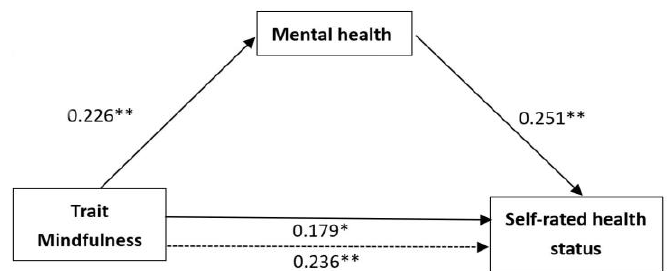
Figure 2. The mediation model of self-rated health (Note: the dotted line denotes that the effect of trait mindfulness on self-rated health is not included as a mediator). * p < 0.05, ** p < 0.01.